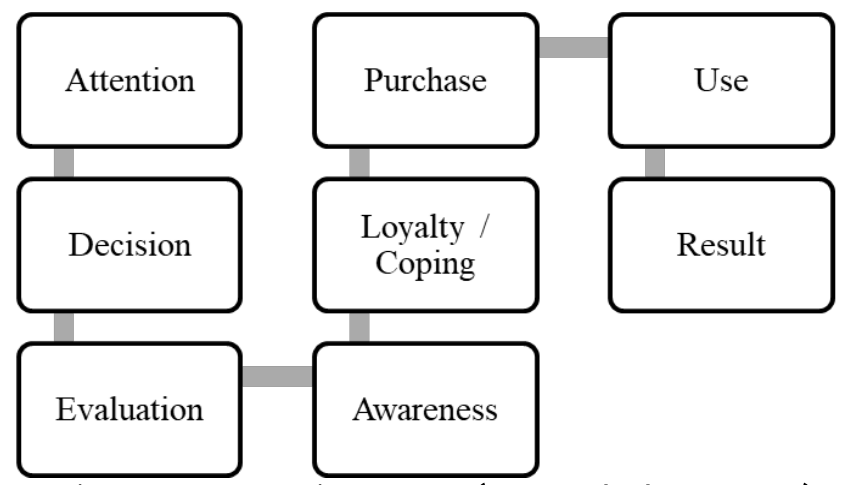
Fig1: Customer experience process (Meyer and Schwager,